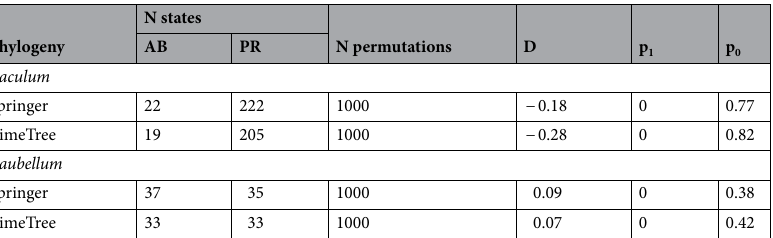
Table 1. D statistic for phylogenetic signal. Calculation of D statistic for the phylogenetic structure of two binary variables (i.e., baculum and baubellum ) considering both phylogenies by Springer 71 and Timetree 72 . Counts of states (either absence—AB or presence—PR), total number of permutations (N permutation), sum of changes in estimated nodal values of both binary traits along edges in the phylogeny (D), a p value giving the result of testing whether D is significantly different from one (p 1 ), a p value giving the result of testing whether D is significantly different from zero (p 0 ).